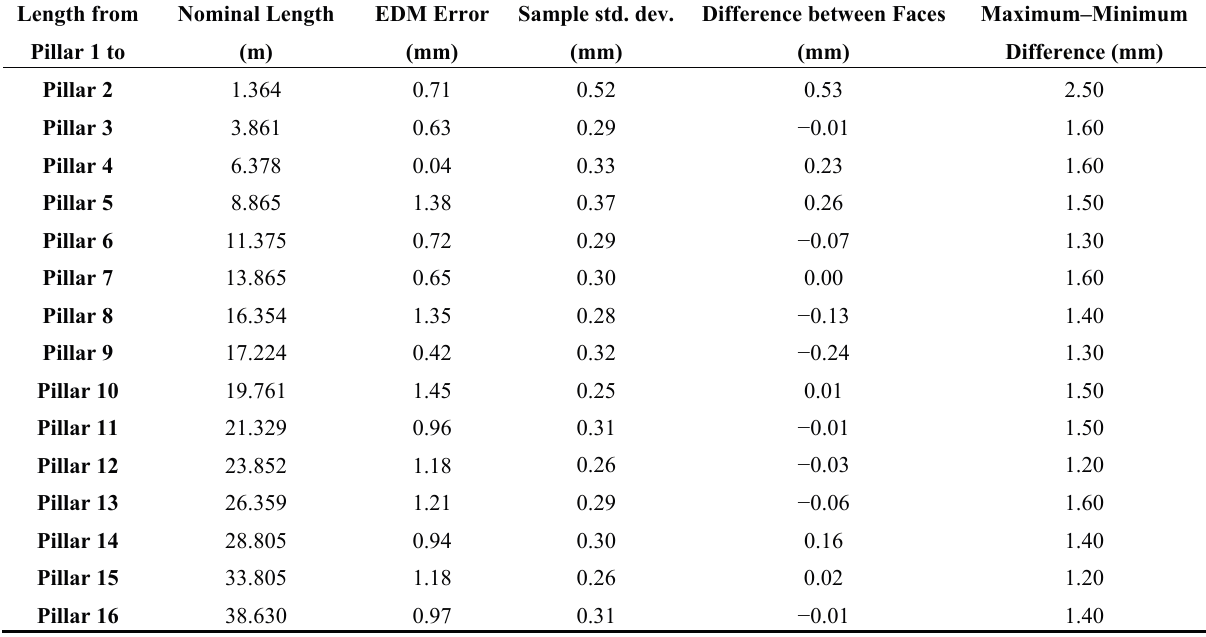
Figure 8. Trimble S6 HP–Absolute errors in six epochs. Table 3. Trimble S6 HP (23 February